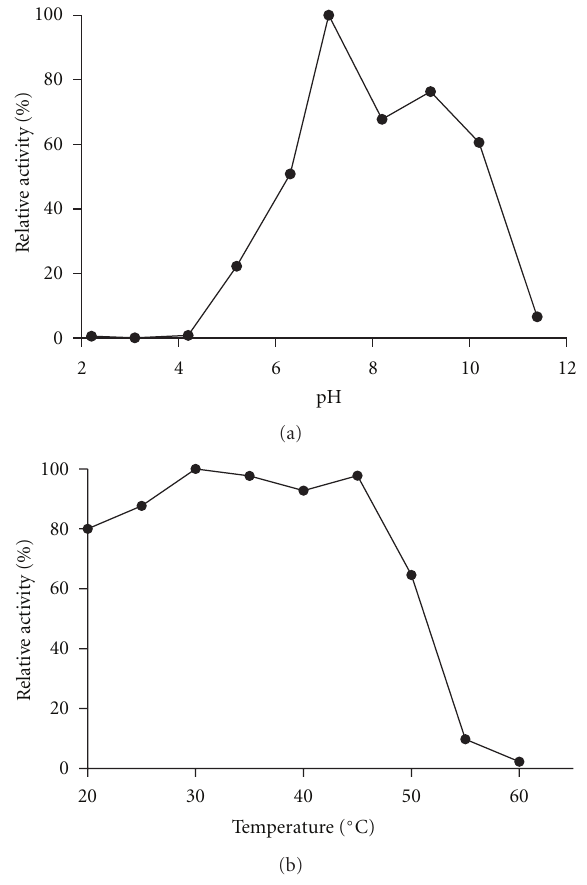
Figure 3: E ff ect of pH and temperature on the CeSP activity. (a) Optimum pH for the protease activity was determined in the H-D- Pro-Phe-Arg-pNA hydrolysis in 50mM acetate/borate/phosphate bu ff er in the pH range of 2.0 to 11.5 for 20min at 37 ◦ C. (b) For thermal stability studies, CeSP was kept in Tris bu ff er pH 7.1 for 30min at di ff erent temperatures (20–60 ◦ C). Then, enzyme activity in the H-D-Pro-Phe-Arg-pNA hydrolysis was determined at 37 ◦ C in the same bu ff